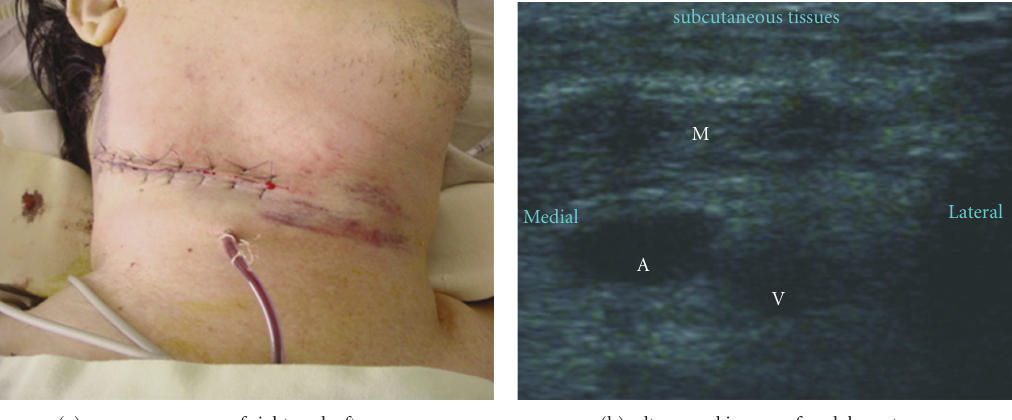
Figure 2: Delayed right neck hematoma. (a) Gross appearance of the neck after surgery. (b) Ultrasound image of right neck showed edematous muscles and swelling connective tissues. No thrombus in the jugular vein: common carotid artery (A), internal jugular vein (V), and edematous muscle layers